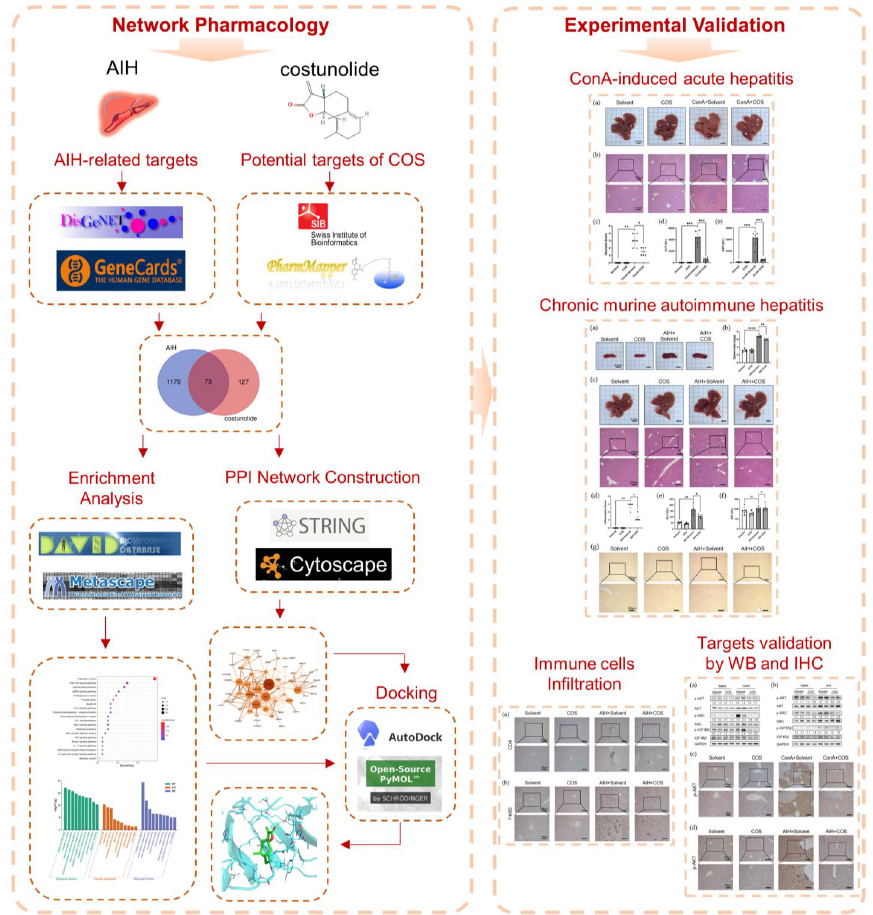
Figure 1. Flow chart of research. Detailed procedures of analysis are described in Materials and Methods. Briefly, AIH-related targets were collected from DisGeNET and GeneCards. The potential targets of costunolide were obtained from SwissTargetPrediction and PharmMapper. The potential targets of costunolide in AIH were generated by taking intersection of targets above. KEGG and GO enrichment analysis were performed using DAVID and Metascape. STRING database and Cytoscape were used for the construction of PPI network analysis. The docking between costunolide and key targets were conducted by PyMol and AutoDock. In vivo experiments were performed to verify the effect of costunolide on AIH and its underlying mechanism.